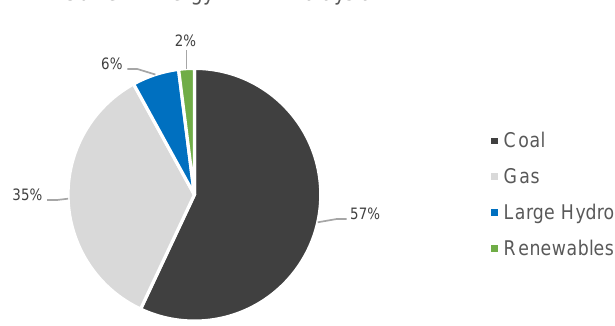
Figure 2. Current energy mix in Malaysia [36].